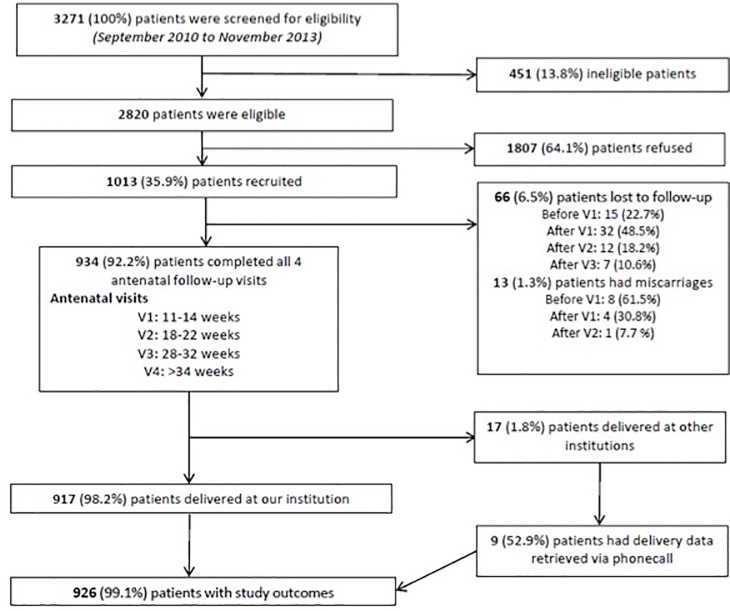
Flowchart showing the NORA study recruitment process.